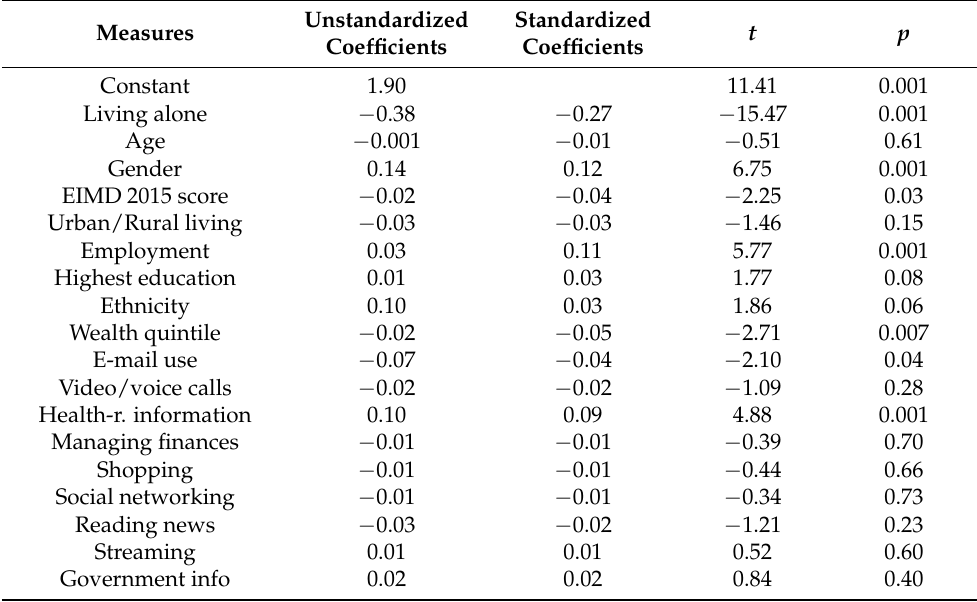
Table 3. Regression Model with Subjective Loneliness as the Criterion